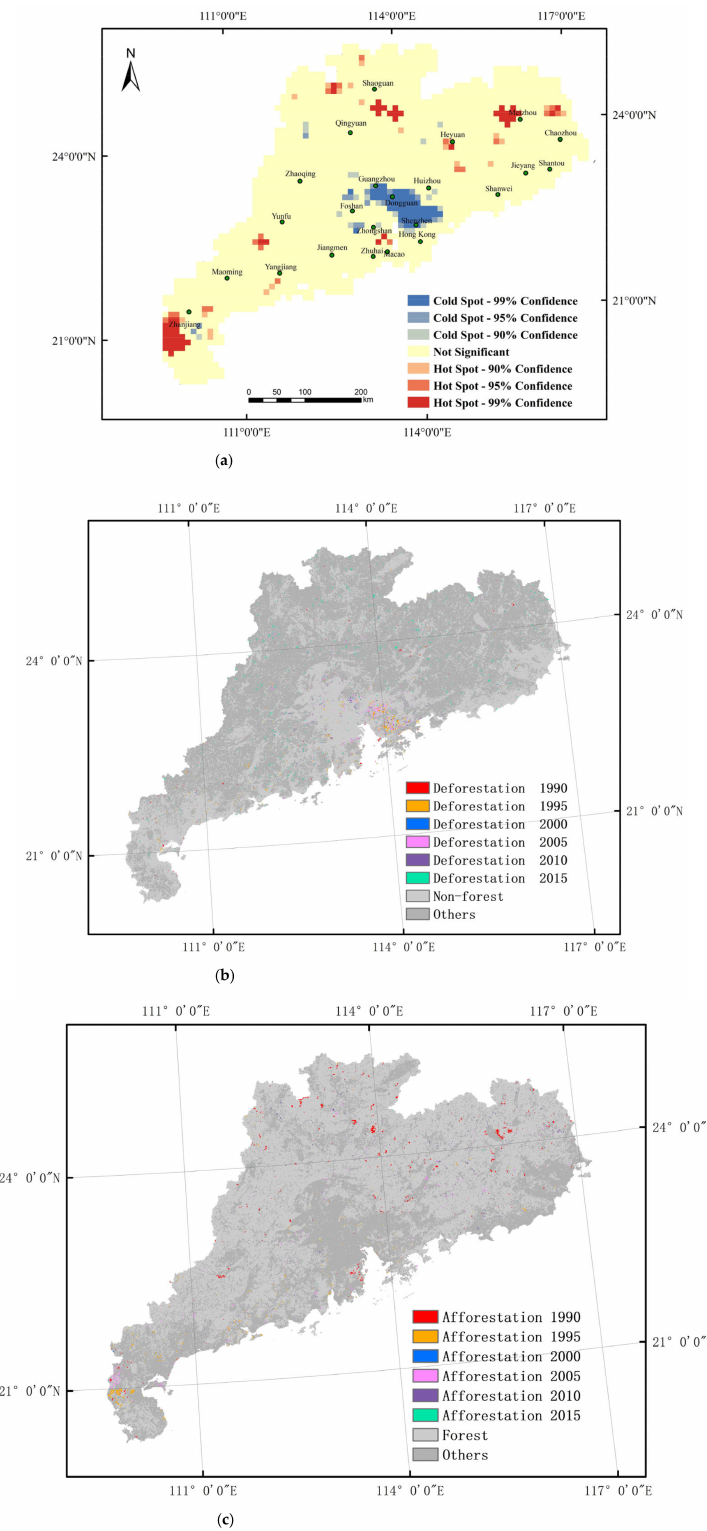
Figure 6. ( a ) Hot spot map of forest change; ( b ) spatial distribution of deforestation; ( c ) spatial distribution of